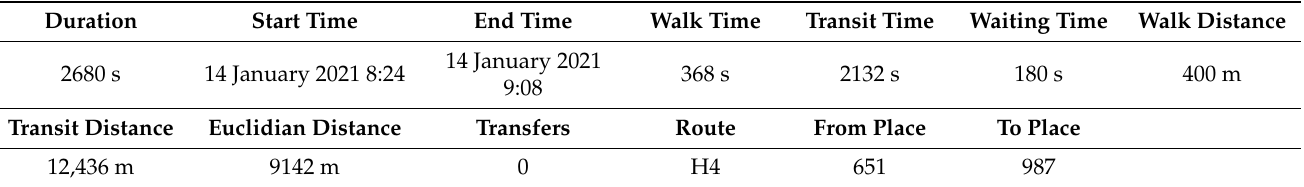
Table 1. Data generated by a request in OTP.